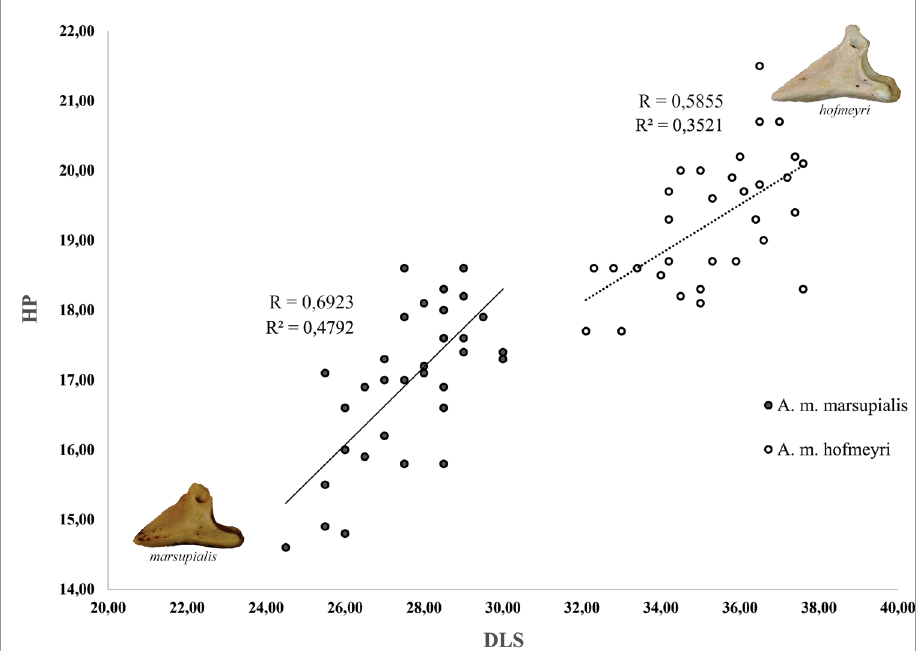
Figure 3: Bivariate plot of variables DLS ((greatest) diagonal length of sole) and HP (height in the region of the extensor process) measured for Antidorcas marsupialis . Smaller A. m. marsupialis was clearly differentiated from larger A. m. hofmeyri , with no overlap in